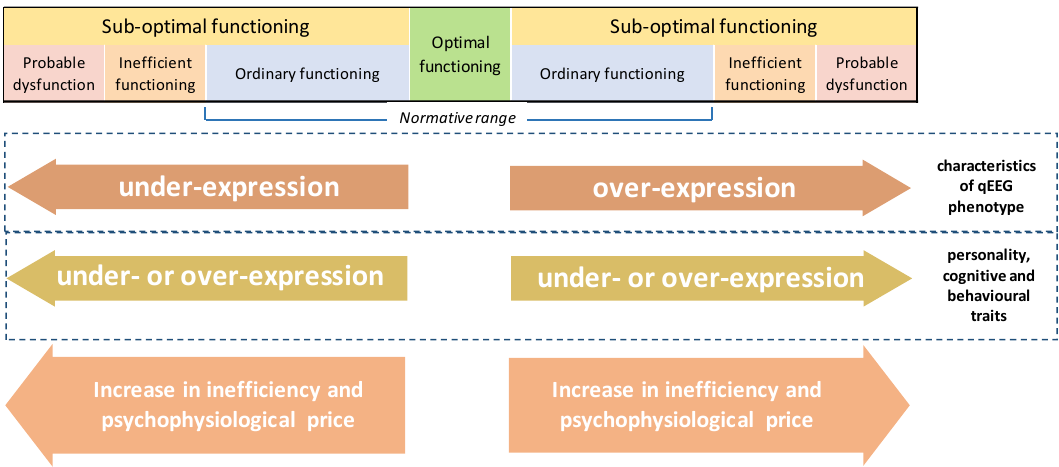
Figure 5. The norm-pathology continuum.